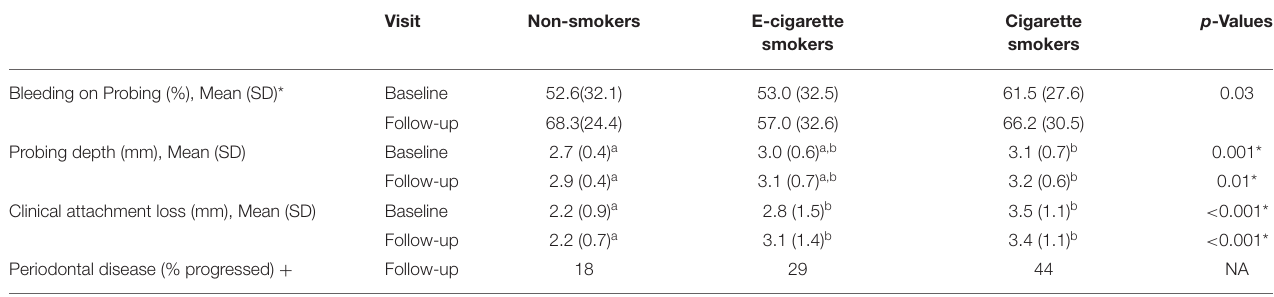
TABLE 3A | Rates of BoP and periodontal disease severity, and levels of, probing depth, and clinical attachment loss as a function of group and time.